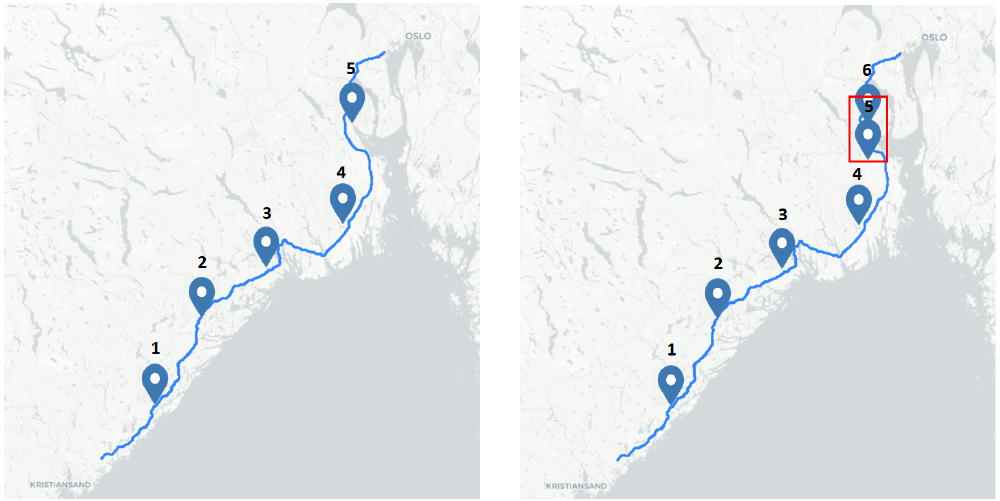
Figure 8. Static